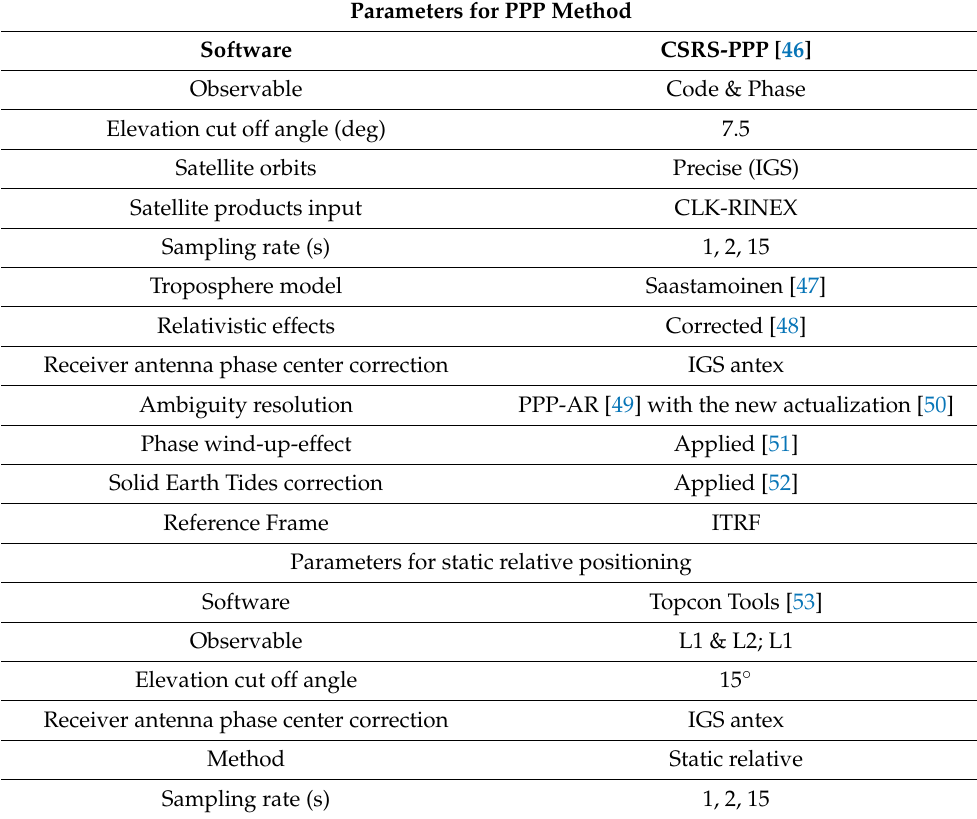
Table 4. Summary of parameters used in the PPP and static relative positioning